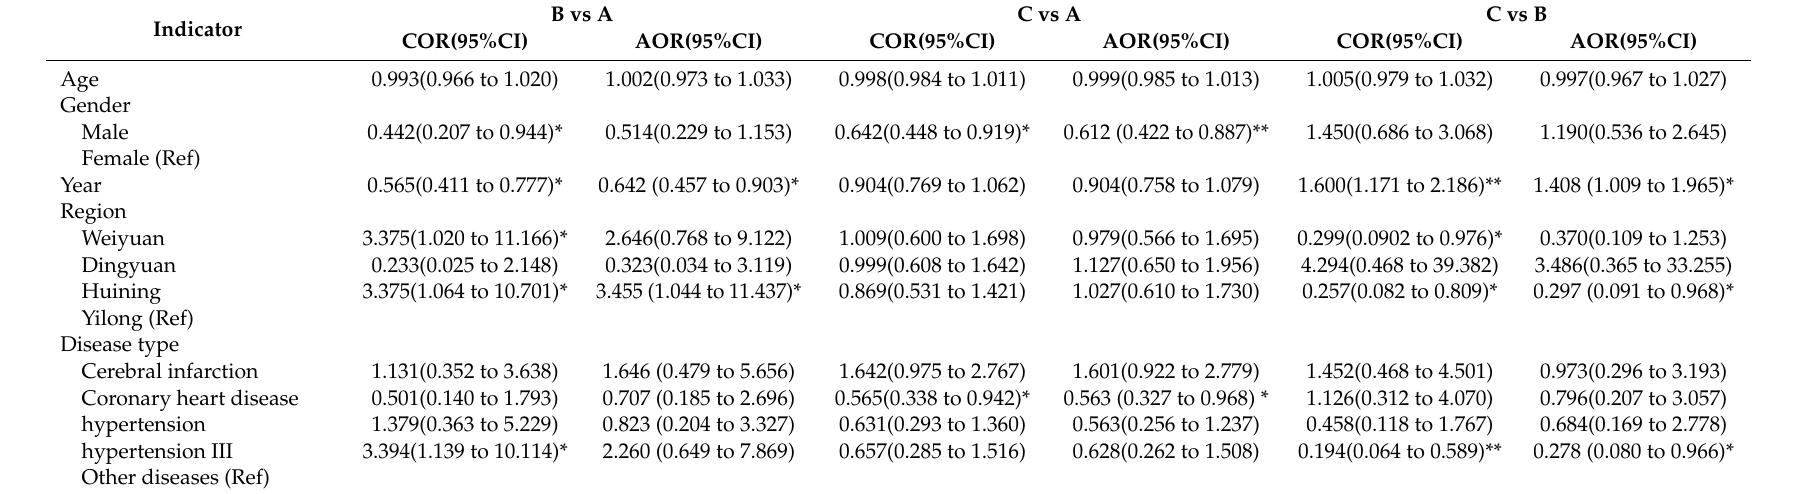
Table 4. Multivariate logistic regression analysis of the positive indicators of patients with CSDs ( n =